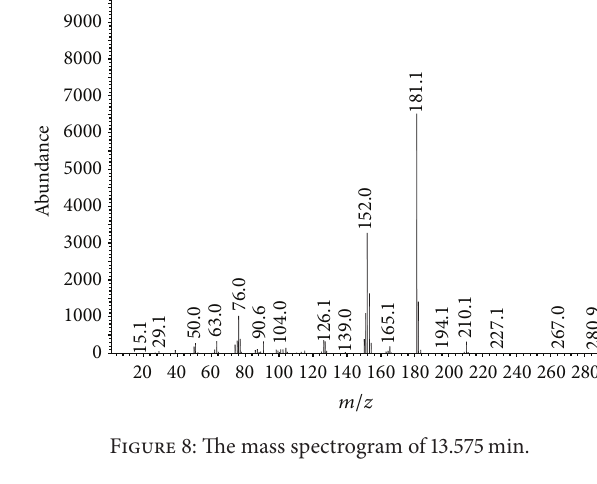
Figure 8: The mass spectrogram of 13.575 min.